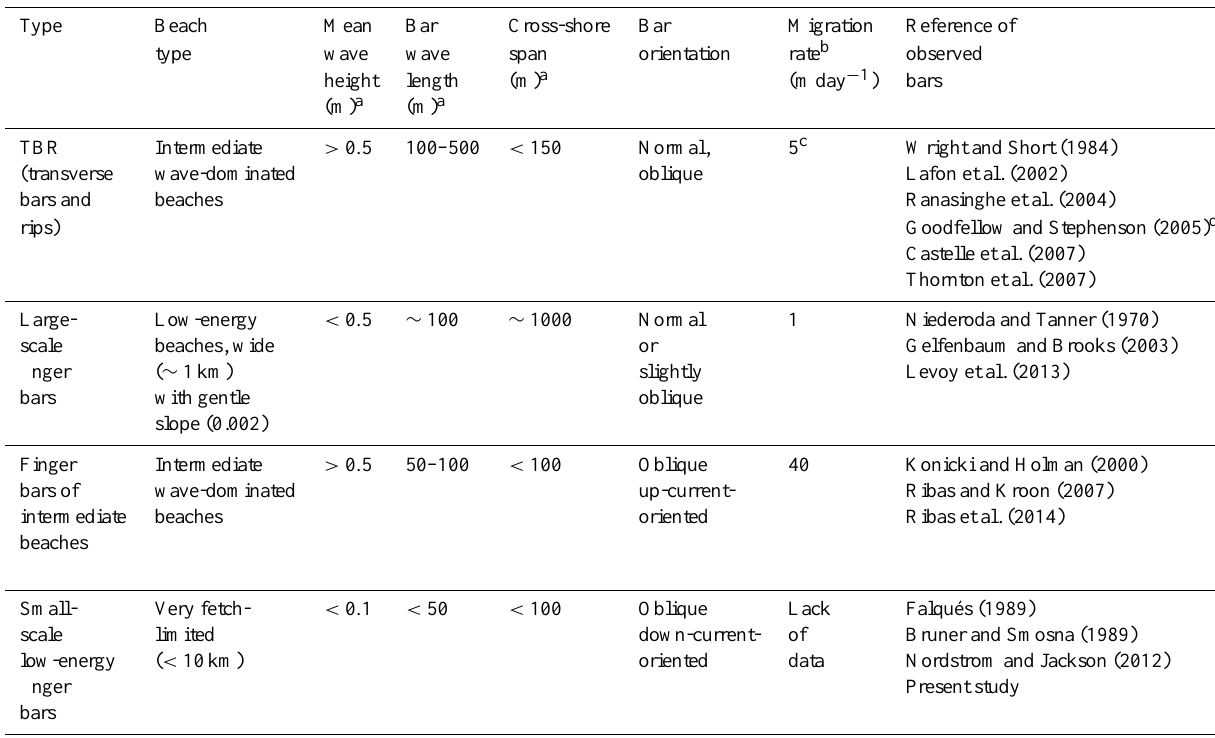
Table 1. Transverse bar types and main